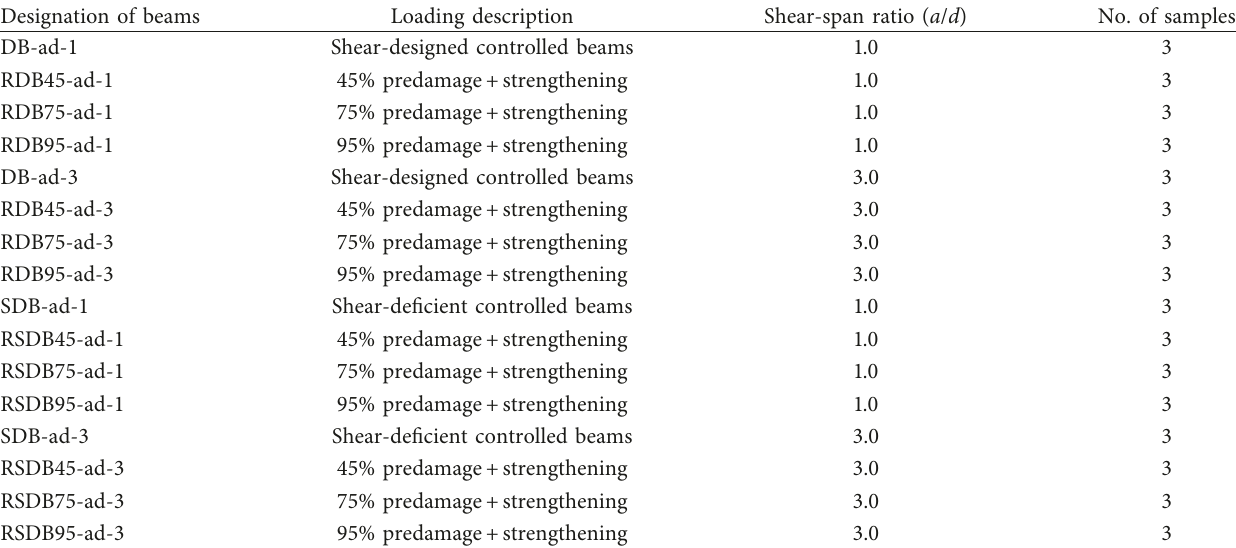
Table 4: Shear-designed and shear-deficient RCC beam designation